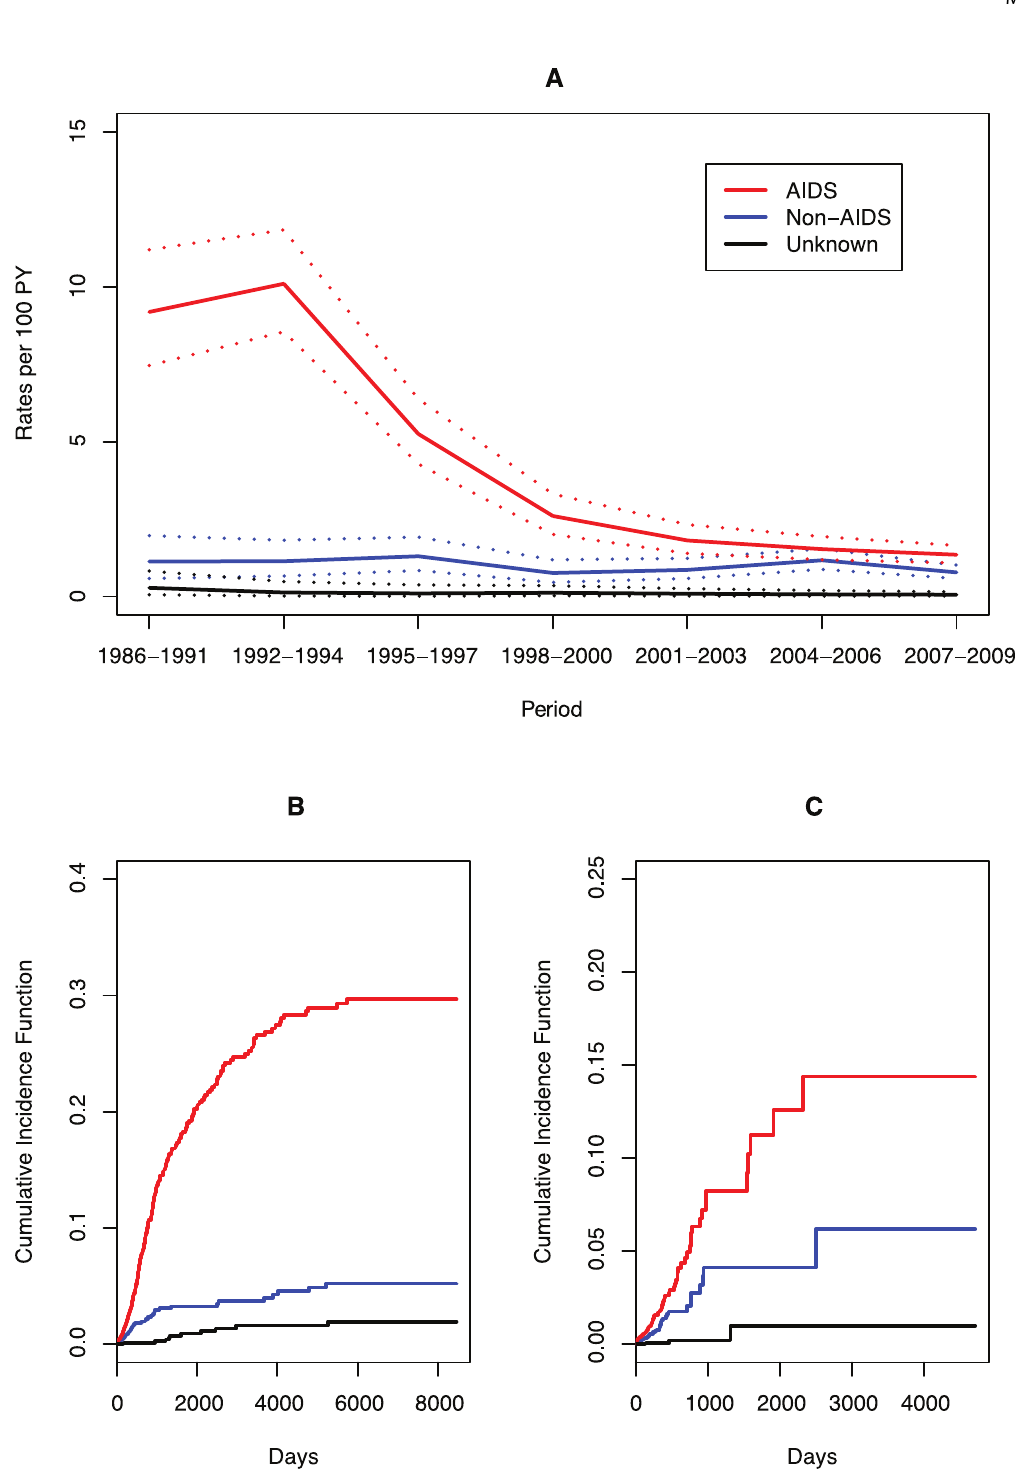
Figure 1. Mortality rates and Cumulative Incidence Functions for AIDS-related, non-AIDS related and unknown causes of death. Mortality rates for AIDS-related, non-AIDS related, and unknown causes of death over calendar periods (A) and Cumulative Incidence Functions for AIDS-related, non-AIDS related and unknown causes of death for the entire cohort (B) and for those enrolling from 1997 onwards (C).